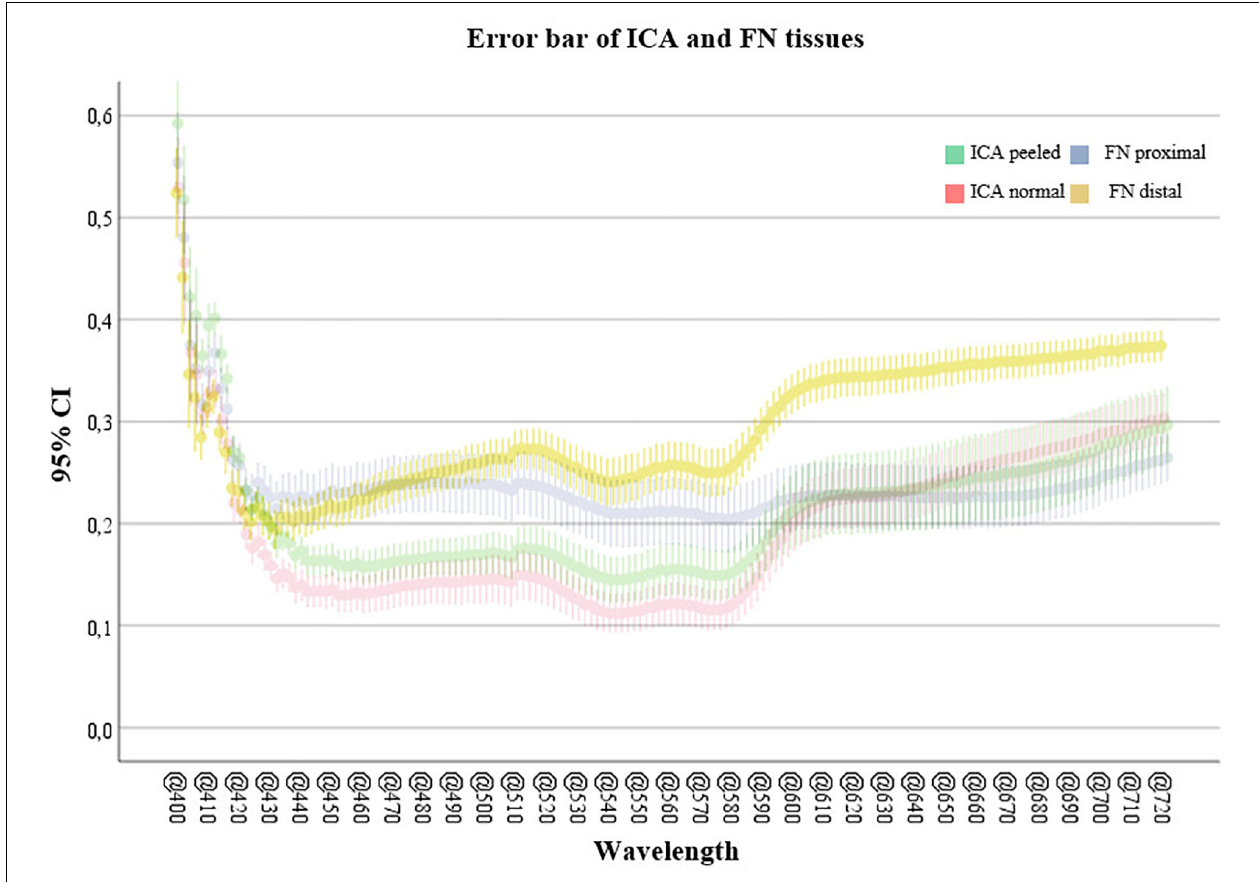
FIGURE 3 | Confidence interval (95%) error bars comparing artery and nerve groups. The highest mean difference is illustrated in the lower and middle wavelength ranges (400–590 nm) between ICA samples and middle to high ranges (490–720 nm) for FN samples. Abbreviations: CI, confidence interval; ICA, internal carotid artery; FN, facial